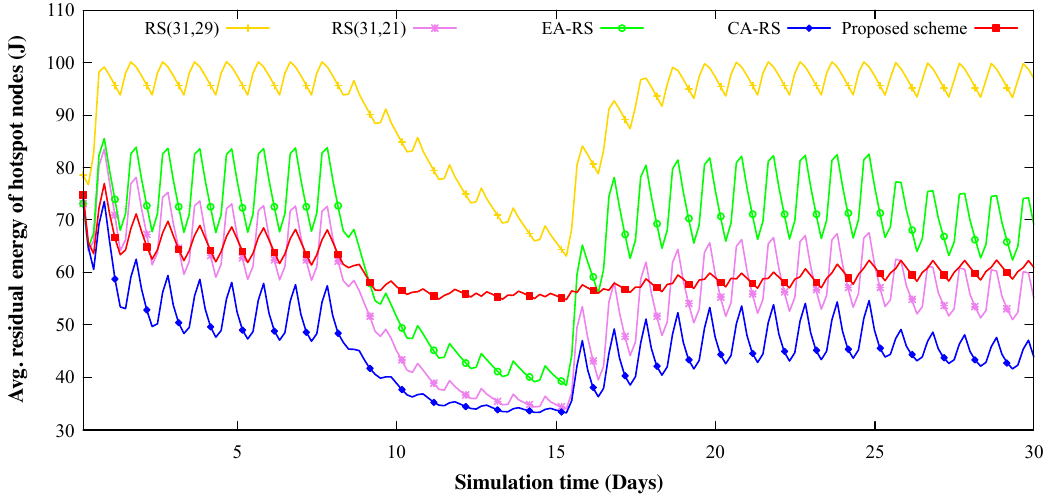
Figure 11. Energy change of hotspot region nodes according to an experiment time for 150 nodes and 0.15 BER (9th ∼ 15th day: rainy, 26th ∼ 30th day: cloudy; others: sunny).